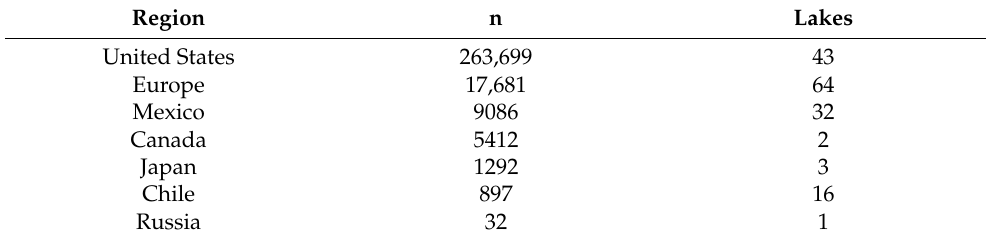
Table 2. Overview of the number of observations and lakes per region in the raw